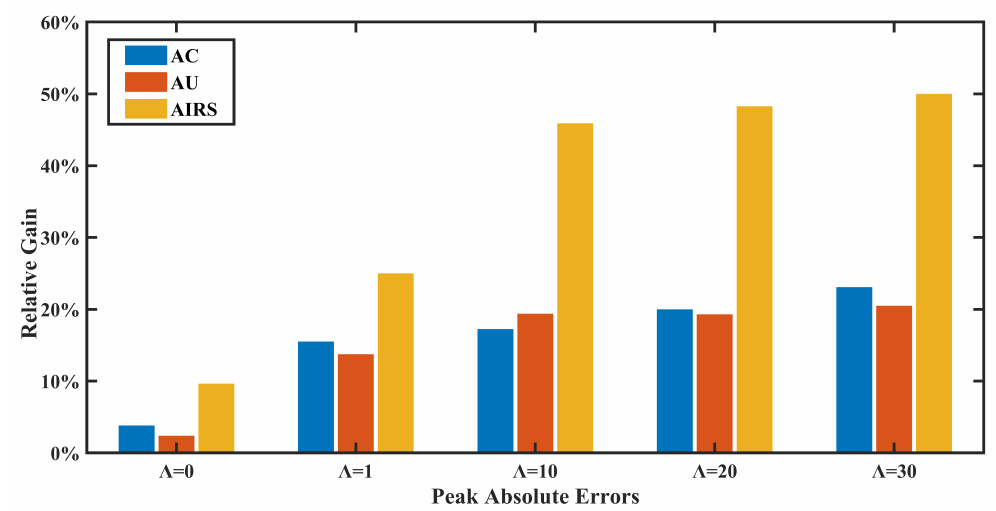
Figure 4. The relative gain of our scheme on CCSDS-123-AC at different peak absolute errors for AC, AU, and AIRS datasets.